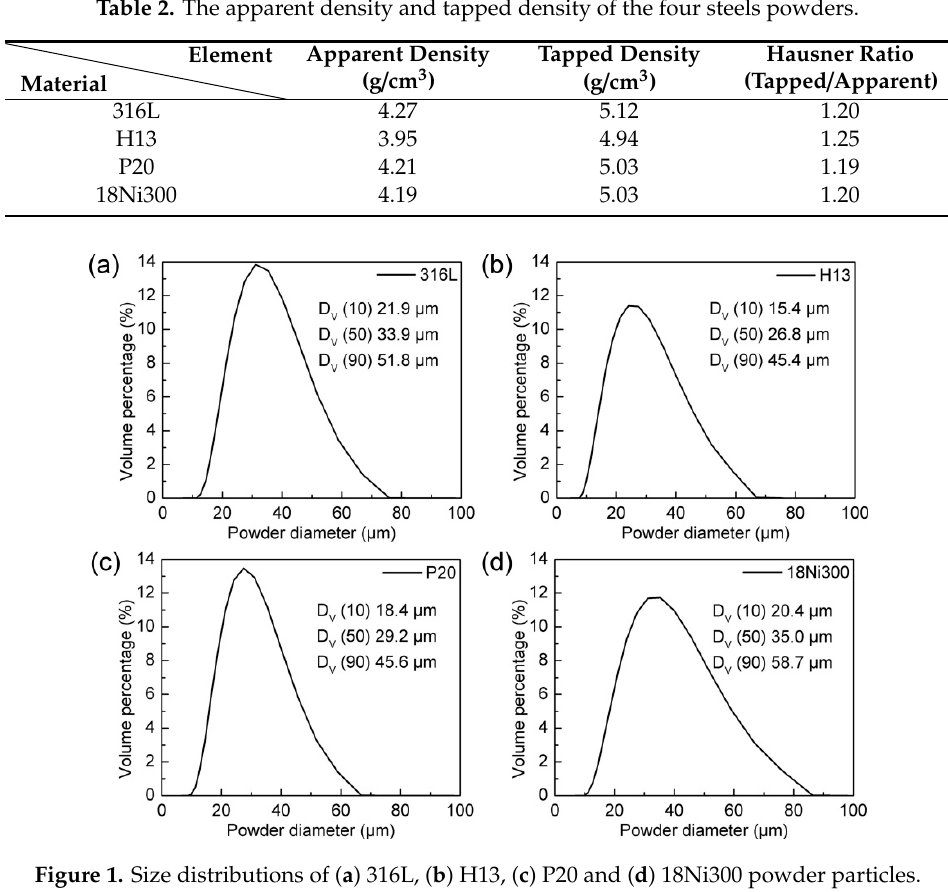
Table 2. The apparent density and tapped density of the four steels powders.